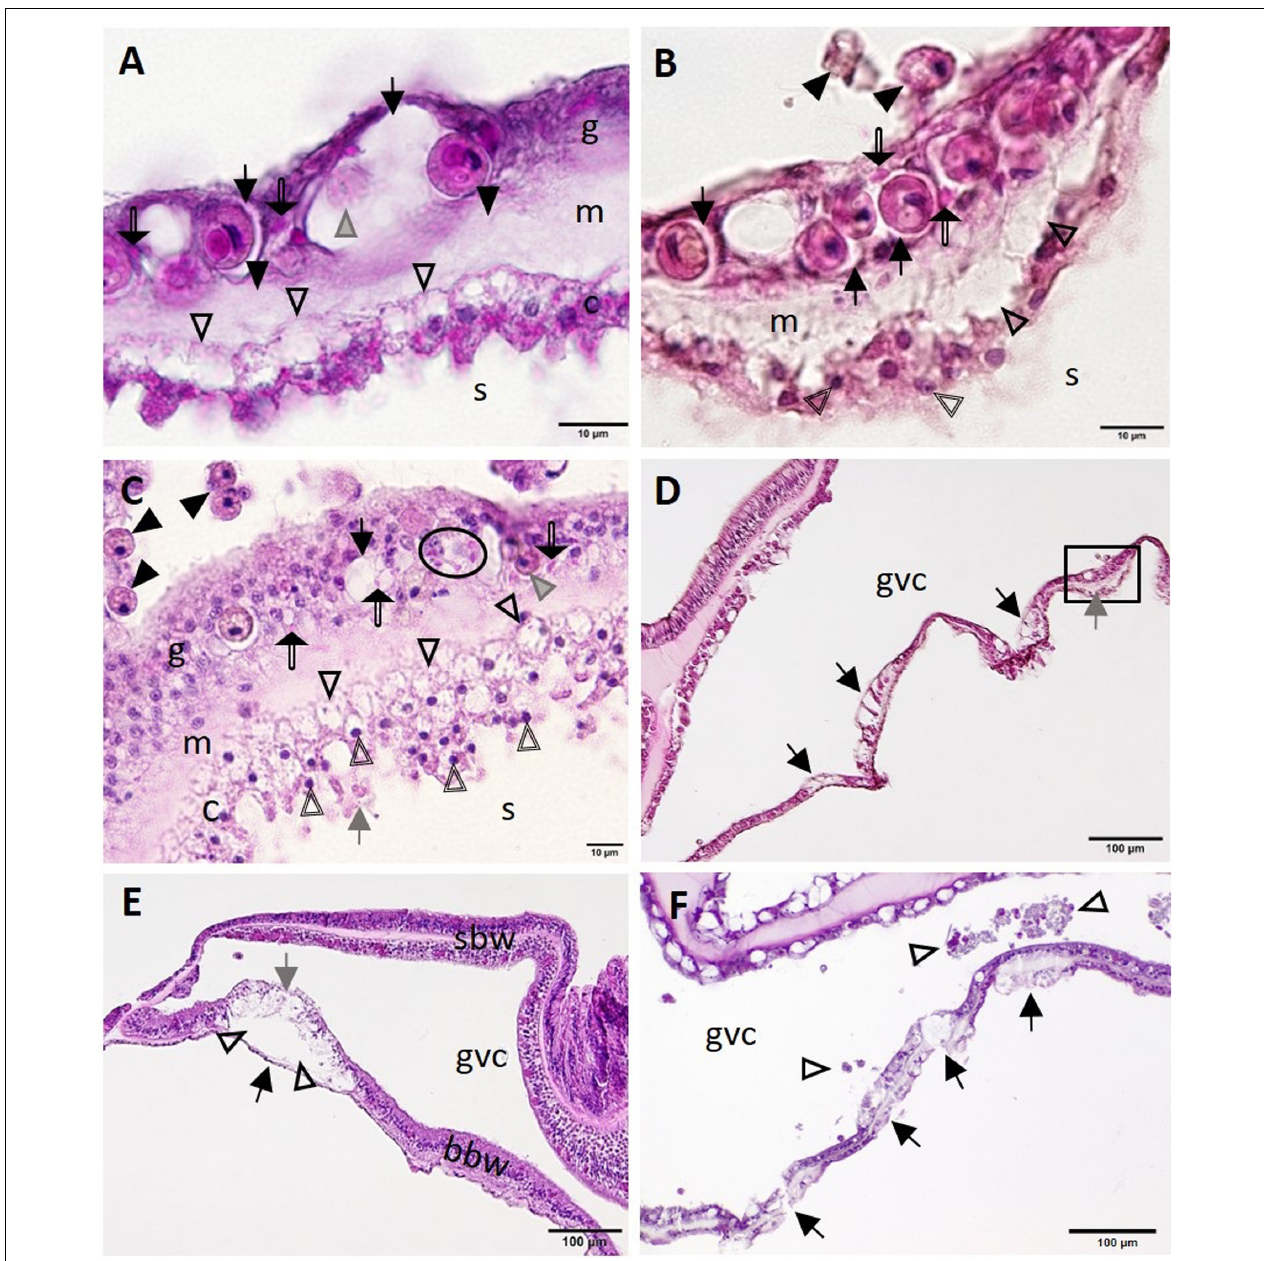
FIGURE 6 | Putative initiation of basal body wall (BBW) lesion formation in Montastraea cavernosa (A–D,F) and early lytic necrosis (LN) lesion in Dendrogyra cylindrus (E) . (A) Initial mesogleal swelling and edema (closed arrowheads), swelling of zooxanthella symbiosomes (arrows), necrosis of a zooxanthella (gray arrowhead), crystalline inclusion bodies (CIBs) (double-line arrows), and hypertrophic calicodermal cells with marked cytoplasmic vacuolation (open arrowheads). (B) High magnification of inset area marked in (D) shows mesogleal edema with marked vacuolation (open arrowheads), swelling of zooxanthellae symbiosomes (arrows), CIBs (double-line arrows), exocytosis of zooxanthellae (closed arrowheads), and pyknotic calicoblasts (double-line arrowheads). (C) Putative calicodermal lesion initiation showing high density of pyknotic nuclei (double-line arrowheads; normal nucleus = gray arrow) and markedly vacuolated calicodermis (open arrowheads) adjacent to skeleton. Note exocytosis of vacuolated zooxanthellae (closed arrowheads), gastrodermal vacuolation (black arrow), necrotic zooxanthella (gray arrowhead), and individual (double-line arrows) or cluster of CIBs (oval) in gastrodermis. (D) Four focal areas in the BBW showing gastrodermal vacuolation (arrows) and mesogleal edema (gray arrow) (inset, see B ). (E) Localized LN of the BBW leading to cleft formation (arrowheads) between apparently intact calicodermis (black arrow) and necrotic vacuolated gastrodermis (gray arrow). Note the intact surface body wall (SBW). (F) Multifocal LN in the BBW (arrows) with necrotic tissue and zooxanthellae (arrowheads) sloughed into the gastrovascular canal (GVC). (A,B,D) Apparently healthy reference colony, Dustan Rocks, April 2017; (C) apparently healthy colony, Near Shore Patch, April 2018; (E) diseased colony, Long Key Ledge, April 2018; (F) diseased colony, Broward County, November 2016. (A) Periodic acid–Schiff (PAS); (B–F) Hematoxylin and eosin (H and E). bbw, basal body wall; c, calicodermis; g, gastrodermis; gvc, gastrovascular canal; m, mesoglea; sbw, surface body wall; s,